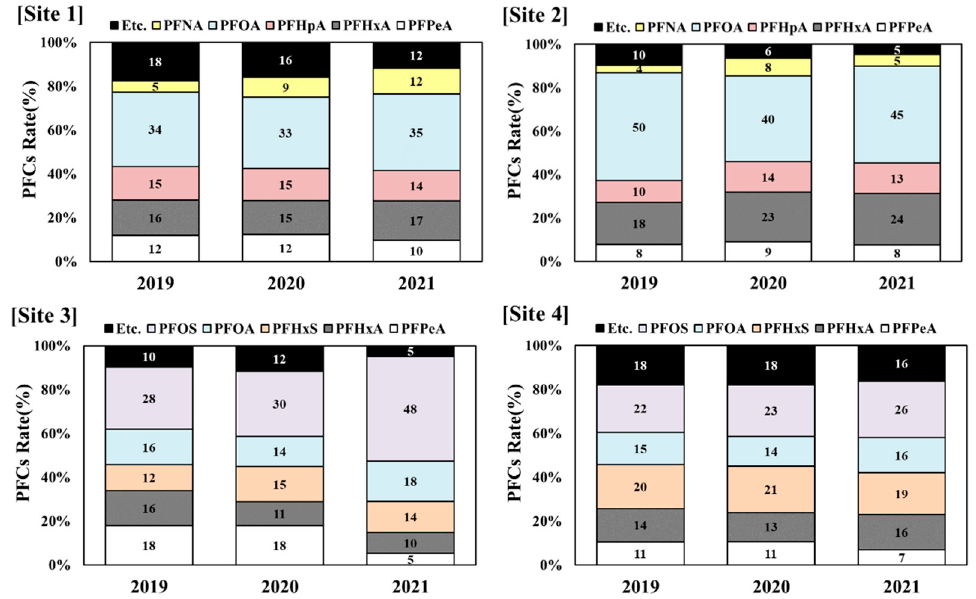
Figure 5. Distribution of PFASs in each intensive monitoring site. ※ Site-1, -2, etc.: PFBA, PFNA, PFDA, PFUnDA, PFDoDA, PFTrDA, perfluorotetradecanoic acid (PFTeDA) PFBS, PFHxS, PFOS, perfluorodecane sulfonate (PFDS). ※ Site-3, -4, etc.: PFBA, PFHpA, PFNA, PFDA, PFUnDA, PFDoDA, PFTrDA, PFTeDA PFBS,